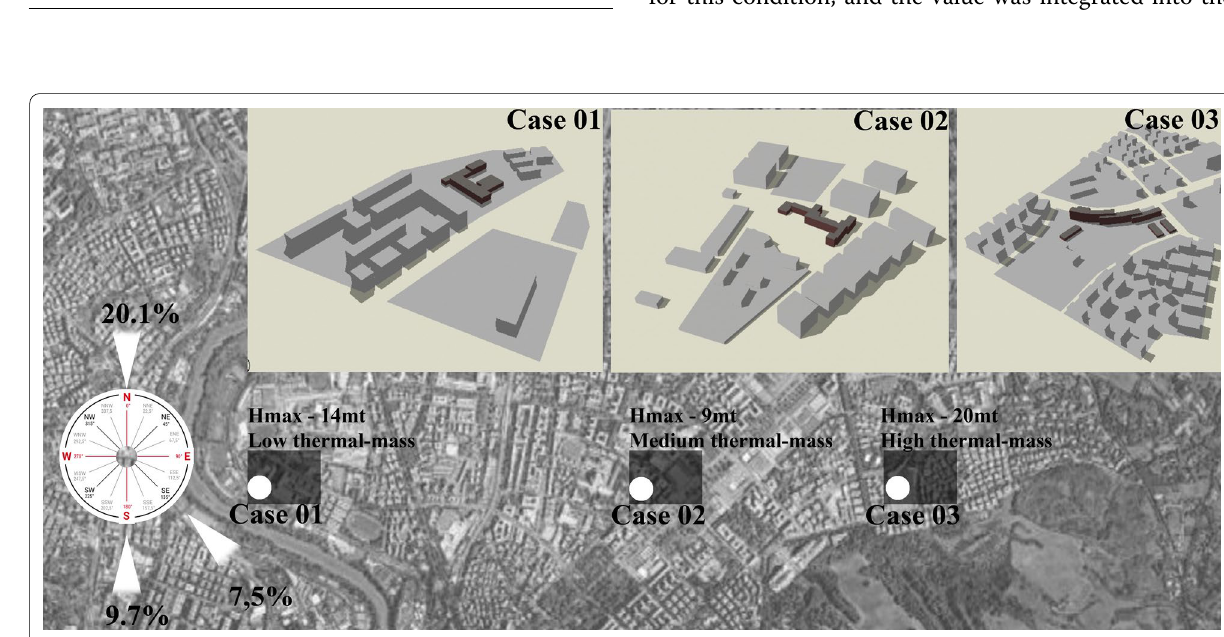
Fig. 3 Case studies features: urban patterns, building morphologies and wind-data